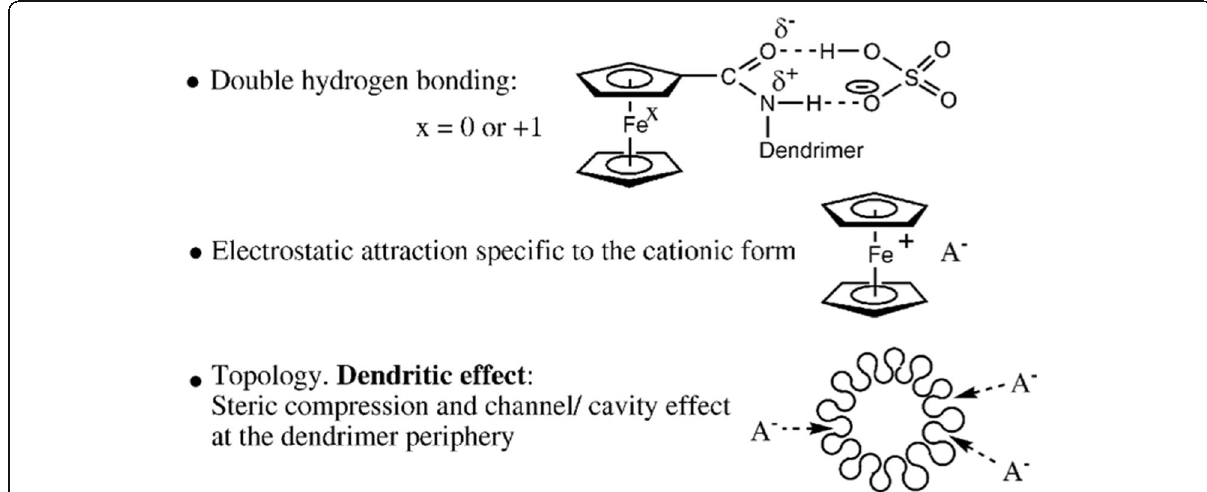
Fig. 3 The three factors acting in synergy explaining the recognition and sensing by amidoferrocene-terminated dendrimers of oxo-anions (HSO 4 − , H 2 PO 4 − and ATP 2 − ) and the remarkable positive dendritic effect in anion redox sensing